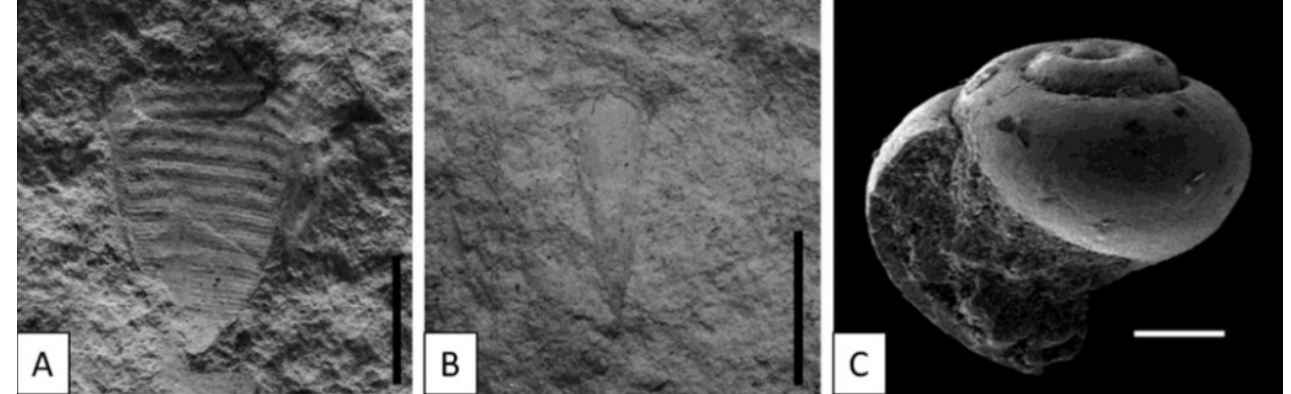
Figure 15. Pteropods from the Middle Miocene deposits in Medvednica Mt. (position 1 at Figure 3); ( A ) Clio fallauxi (Kittl, 1886); ( B ) Vaginella austriaca Kittl, 1886; ( C ) Limacina valvatina (Reuss, 1867). Clio and Vaginella occur in Early–Middle Badenian (Langhian) deposits at the Vejalnica locality, while Limacina is more common in the Late Badenian (Serravallian) deposits of the Marija Bistrica locality (localities shown in Figure 10). Scale bars: A, B: 5 mm; C: 100 μ m ([59], modified).